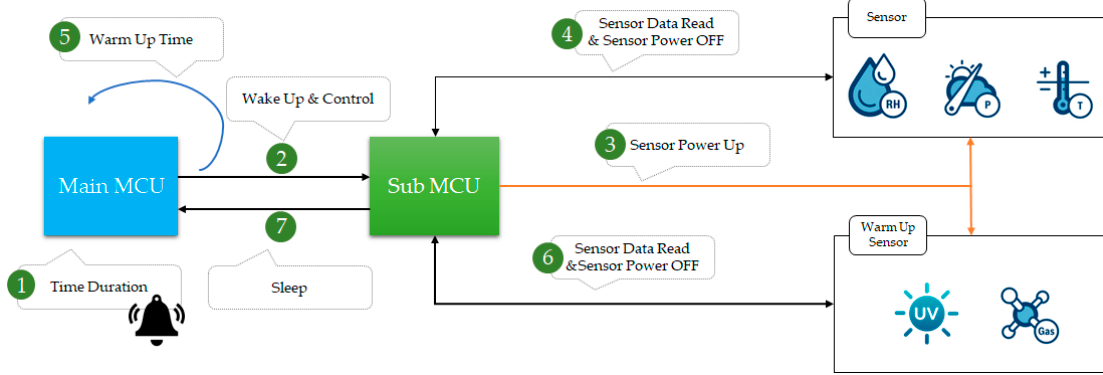
Figure 9. Multiple sensor control architecture of smart tag.